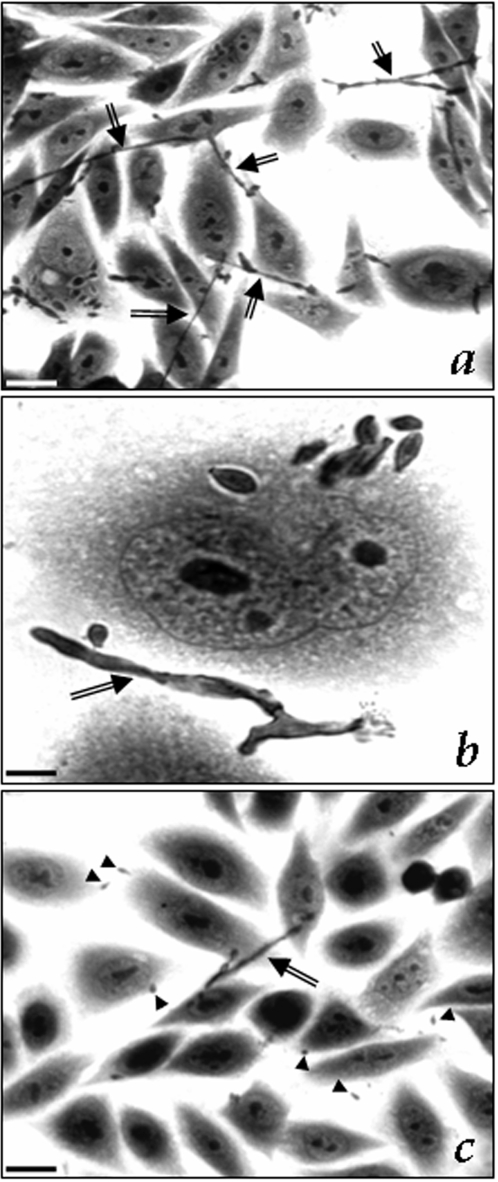
Effect of aspartyl HIV PIs on the F. pedrosoi morphological transition (conidia into mycelia transformation) after the interaction with epithelial cells (CHO).In this set of experiment, conidia of F. pedrosoi were initially untreated (a and b) or treated (c) with 100 µM of HIV aspartyl PIs for 1 hour, washed in PBS and then interacted with CHO cells for 4 hours. Optical microscopy of the interaction showed that in the control system, some conidial cells transform in hyphae, as indicated by the arrows, showing the well-known differentiation process triggered by the contact of conidia with host cells. Conversely, when conidia were pre-treated with aspartyl PIs, especially saquinavir (c), the number of hyphae is drastically diminished. Arrowheads show the conidia. Scale bars: (a, c), 10 µm; (b), 1 µm.